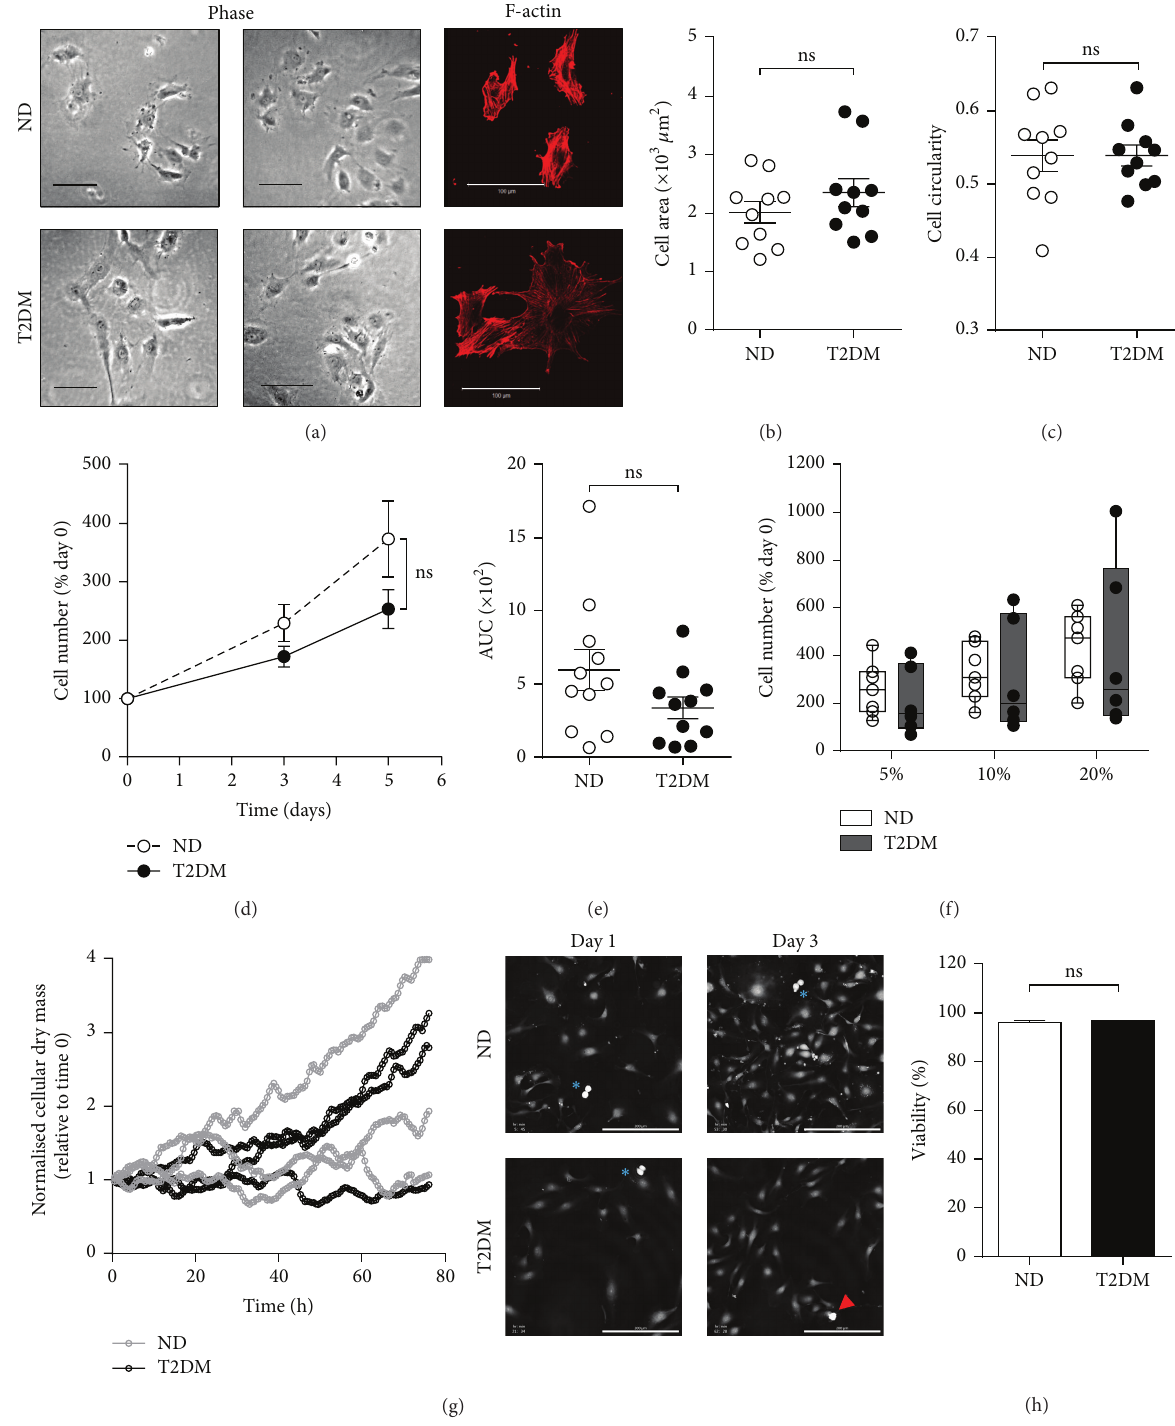
Figure 1: SV-EC morphology and proliferation. (a) Morphology of ND and T2DM populations in culture, scale bar = 100 𝜇 m. Left-hand panels = representative phase images from two ND and two T2DM-EC, right-hand panels = rhodamine phalloidin staining of F-actin cytoskeleton at × 400 magnification from one ND and one T2DM-EC population. (b) Spread cell area and (c) mean circularity (roundness) of 50 cells per population of ND and T2DM-EC were measured using ImageJ (both 𝑛 = 10 , ns = not significant). (d) Proliferation was quantified by direct counting of live cells over 5 days in full growth medium. Data are expressed as the percentage increase in cell number from day 0 count and (e) area under curve (AUC) ( 𝑛 = 11 , ns = not significant). (f) SV-EC were treated with 5–20% FCS and viable cells counted on day 5. Data is presented as box-and-whiskers with the median indicated ( 𝑛 = 6 -7, ns = not significant). (g) Cells from three ND and three T2DM donors were monitored over a period of 3 days in full growth medium on a Phase Focus PFVL21 system and the relative cellular dry mass plotted over time. Right-hand panel = representative ptychographic images of cells dividing (blue asterisks) and dying (red arrowhead), scale bar = 200 𝜇 m. (h) Cell viability following completion of the ptychographic experiment, 𝑛 = 3 , ns = not